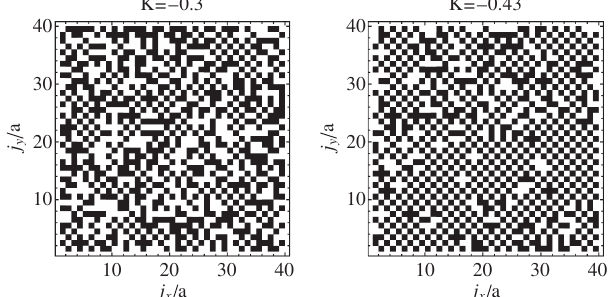
FIG. 9. Typical configurations for the Ising model at two different temperatures. We show the cases far above ( K ¼ − 0 . 3 , on the left) and slightly above ( K ¼ − 0 . 43 , on the right) the transition temperature. The corresponding correlation ð − 0 . 3 Þ ≈ 3 a and ξ ð − 0 . 43 Þ ≈ 40 a . lengths are ξ Ising Ising